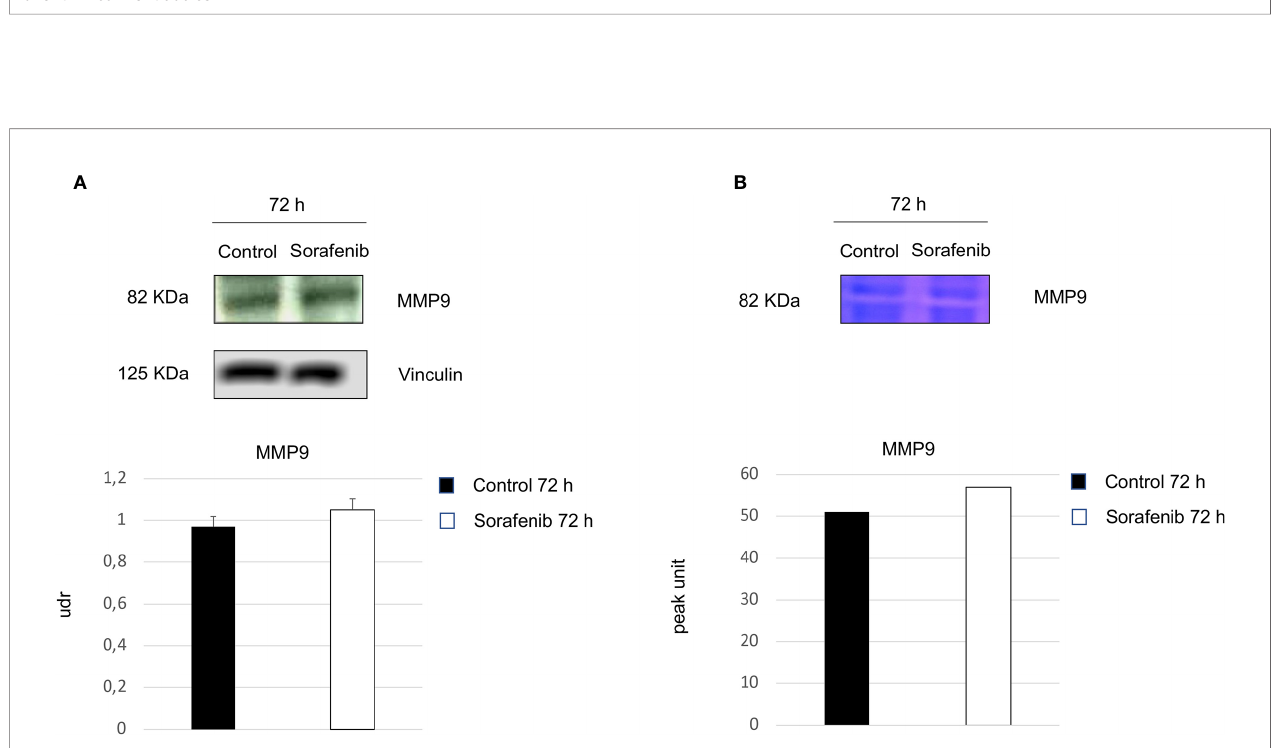
FIGURE 5 | Cells were analyzed at 72 h after sorafenib treatment. Indirect immuno fl uorescence was analyzed by fl ow cytometric histograms for pVEGFR2 (particular of Figure 2A ) (*p<0.05) (A) and by dot plot for N-cadherin in sorafenib-treated and untreated cells (B) . Western blot analyses of Vimentin and Vinculin were performed with 50 µg of protein from untreated and treated cells (**p<0.01) (C) . Proteins were resolved by 10% SDS-PAGE to anable analyses with the anti-vimentin or anti-vinculin antibodies.